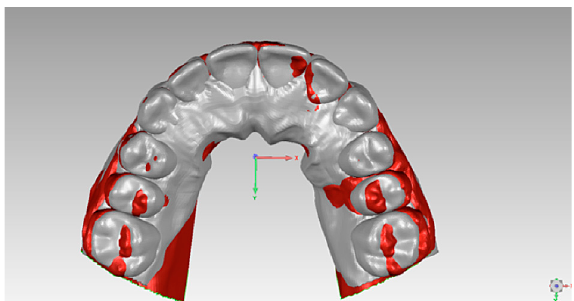
Figure 1. Sample superimposition ( X -axis: Transverse, Y -axis: Sagittal, Z -axis: